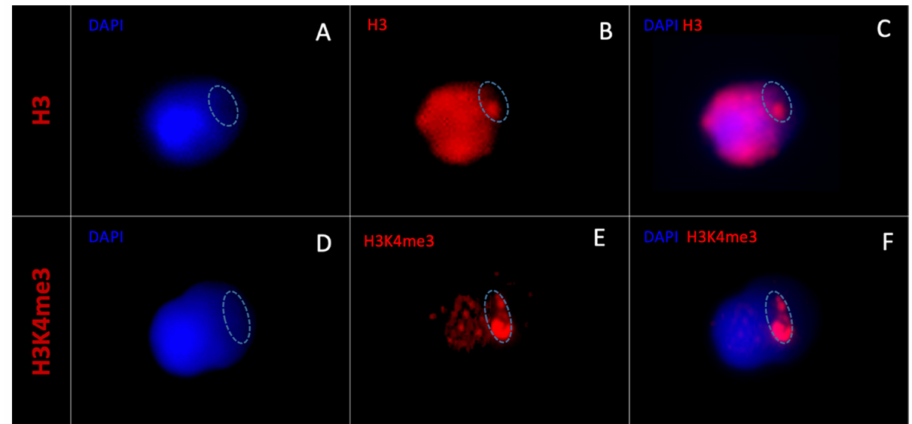
Figure 5. Morphometrically normal spermatozoa with one large vacuole observed with a two- dimensional fluorescence microscope. A vacuolated spermatozoon observed with ( A ) DAPI labelling (blue) and ( B ) histone 3 labelling (red, anti-H3). The vacuole is circled in dotted line. H3 labelling is diffuse and occupies the entire sperm head (( C ) merged DAPI/H3-Cy3). Another vacuolated sperma- tozoon observed with ( D ) DAPI labelling and ( E ) H3K4me3 labelling (anti-H3K4me3). The vacuole is circled in dotted line. H3K4me3 labelling is prevalent in certain areas corresponding to DAPI-free zones (( F ) merged DAPI/H3K4me3-Cy3). DAPI: 4 (cid:48) ,6-diamino-2-phenylindole, Cy3: cyanin3.